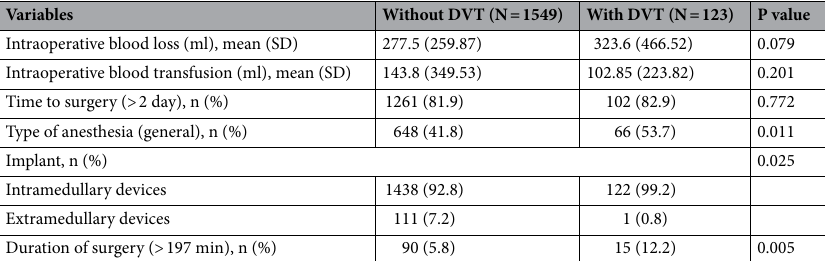
Table 4. Comparison of surgical data between the two groups.